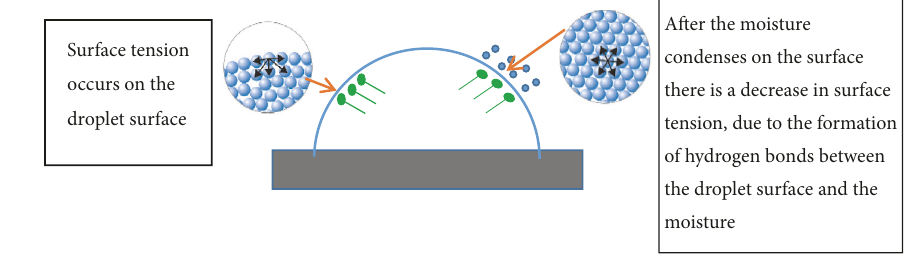
Figure 11: The formation and decrease of surface